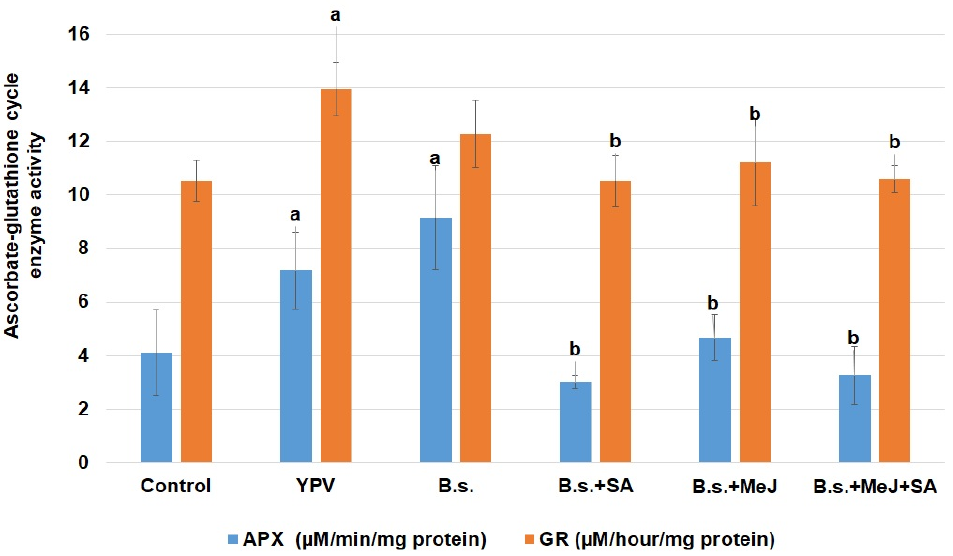
Figure 6. Effect of PVY infection and the mixture of B. subtilis with SA and MeJ application under soil water deficiency on ascorbate-glutathione cycle enzyme activity. Control—health plants; PVY—infected with PVY plants; B.s.— B. subtilis + PVY; B.s. + SA— B. subtilis + salicylic acid + PVY; B.s. + MeJ— B. subtilis + methyl jasmonate + PVY; B.s. + MeJ + SA— B. subtilis + salicylic acid + methyl